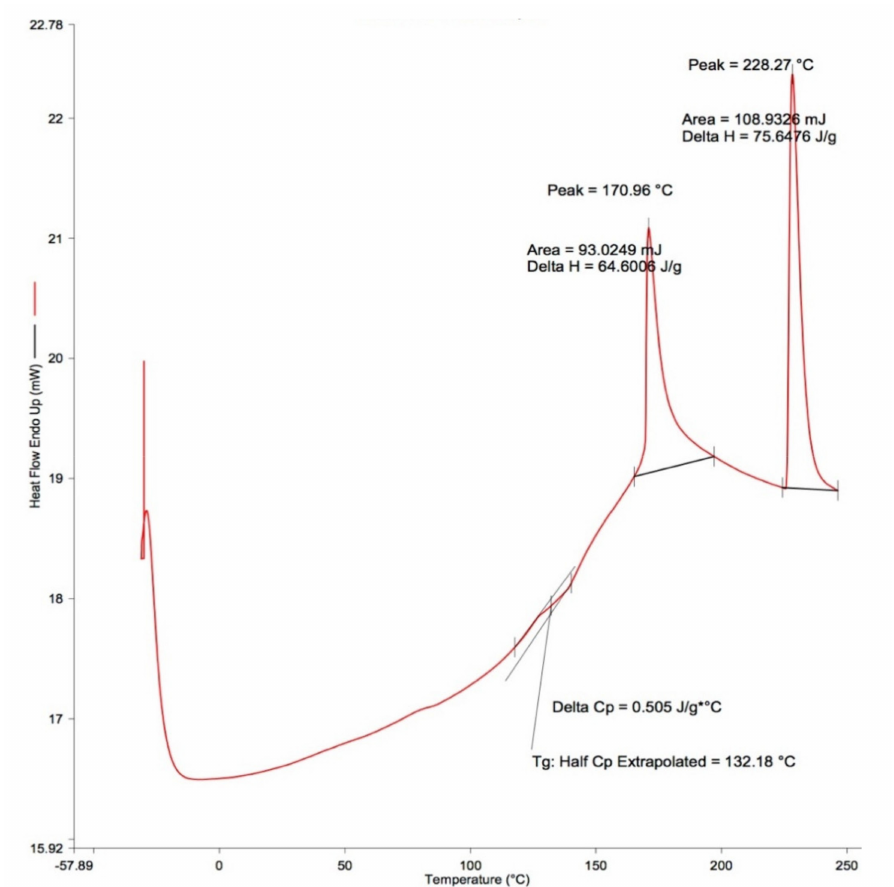
Figure 4. The di ff erential scanning calorimetry (DSC) result of corn starch film without blueberry pomace (BPP)